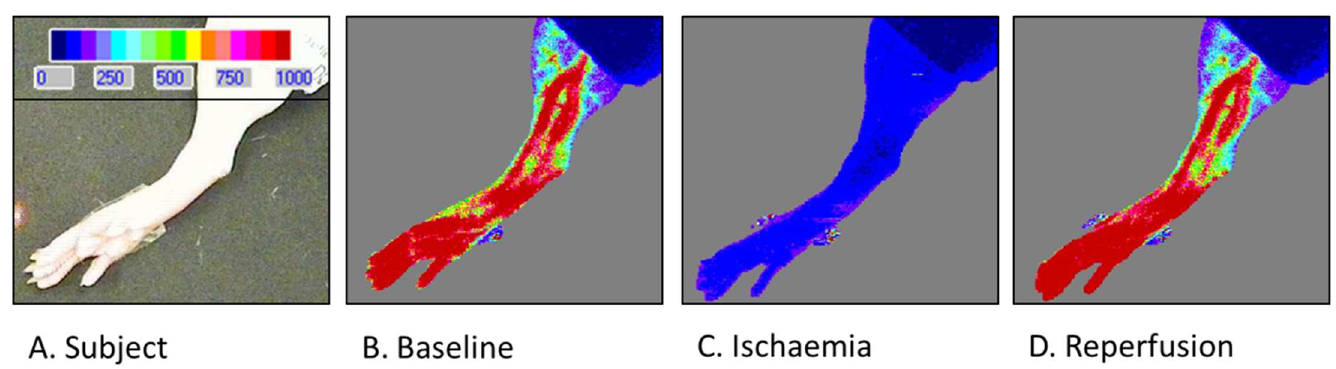
Fig 4. Laser Doppler blood flow assessment in the subject hind limb during RIC and reperfusion. Panel A shows a colour photograph of the subject hind limb. Panel B demonstrates completecessation of blood flow during RIC ischaemia(C) and restoration after